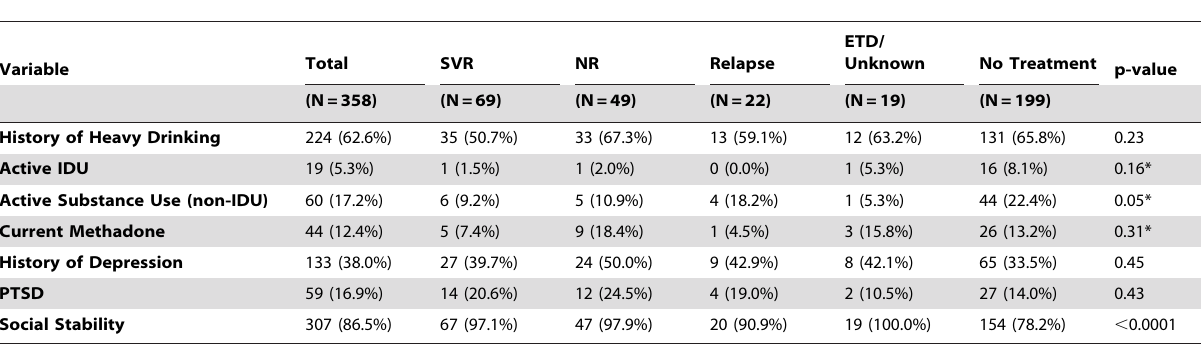
Table 2. Risk Factors Characterizing Treated and Untreated Patient Groups (SFVA Cohort).